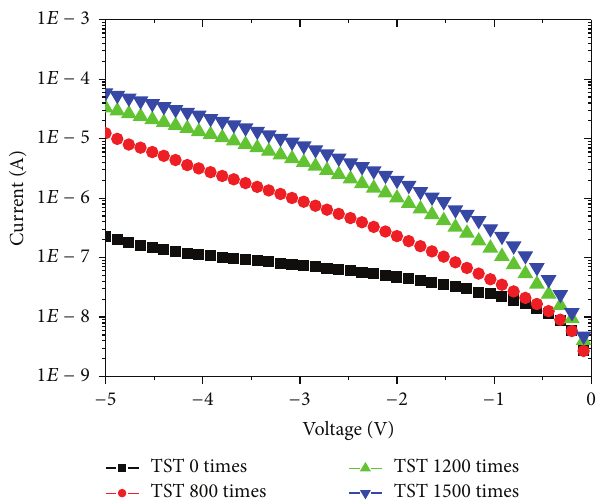
Figure 10: Reverse-bias dark I-V characteristics of the thin-film solar cells grown on electroplate nickel